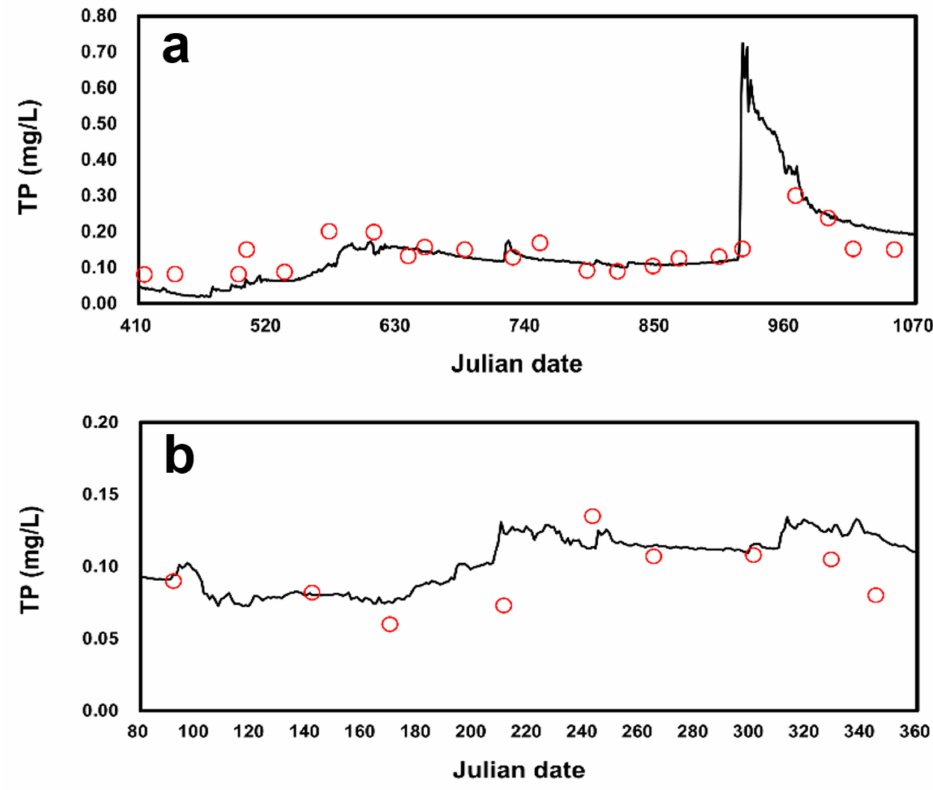
Figure 7. ( a ) Calibration and ( b ) validation result of the T-P concentration of the estuarine reservoir (Zone